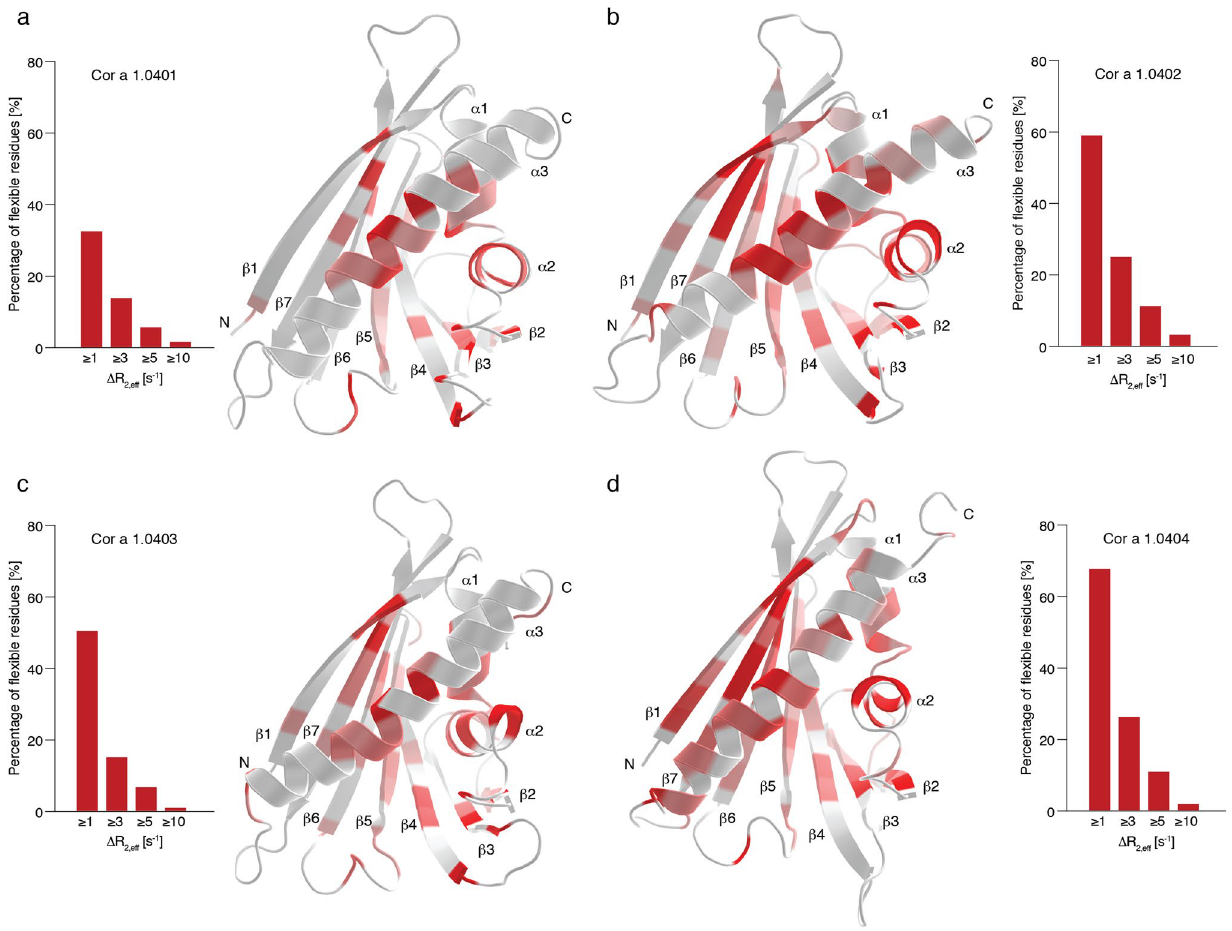
Figure 3. Structural flexibility of the four hazelnut isoforms Cor a 1.0401 ( a ), Cor a 1.0402 ( b ), Cor a 1.0403 ( c ), and Cor a 1.0404 ( d ). The bar plots show the percentage of flexible residues with relaxation dispersion amplitudes (∆R 2,eff values) exceeding 1, 3, 5, and 10 s −1 at 600 MHz. ∆R 2,eff values plotted on the protein backbone with a color gradient from highly flexible (red) to rigid (white), using identical thresholds for all four proteins. Secondary structure elements and the N- and C-termini are